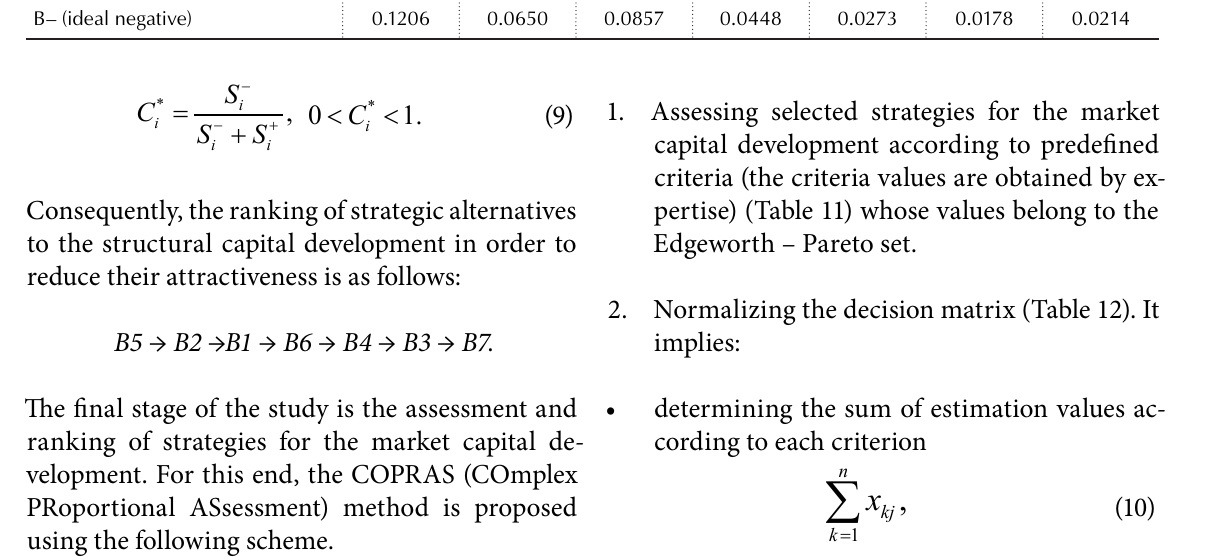
Table 10. Ranking of alternative strategies for the structural capital development of the organization